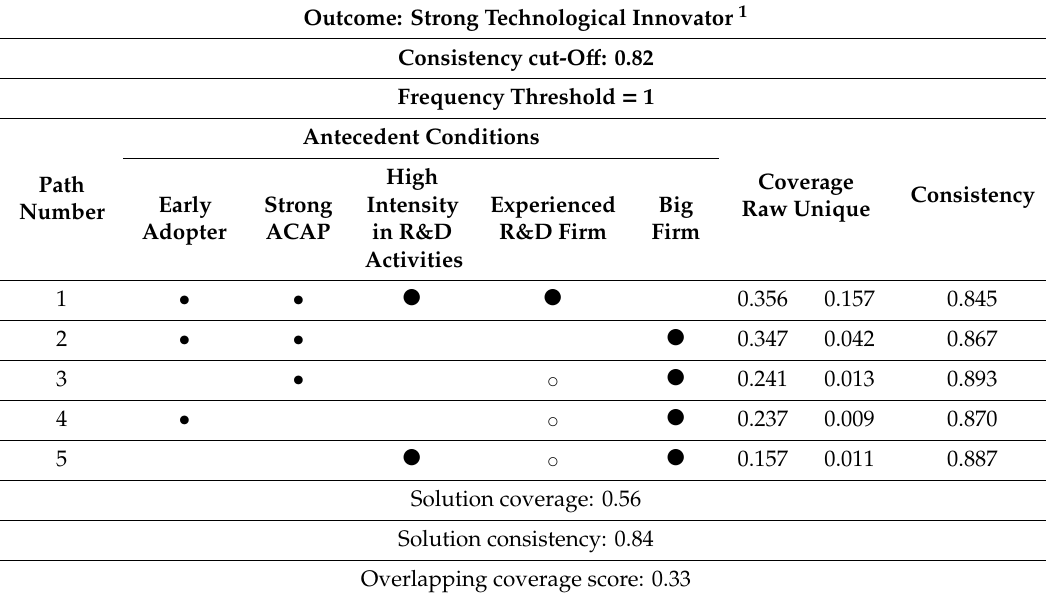
Table 5. Results of the intermediate solution.